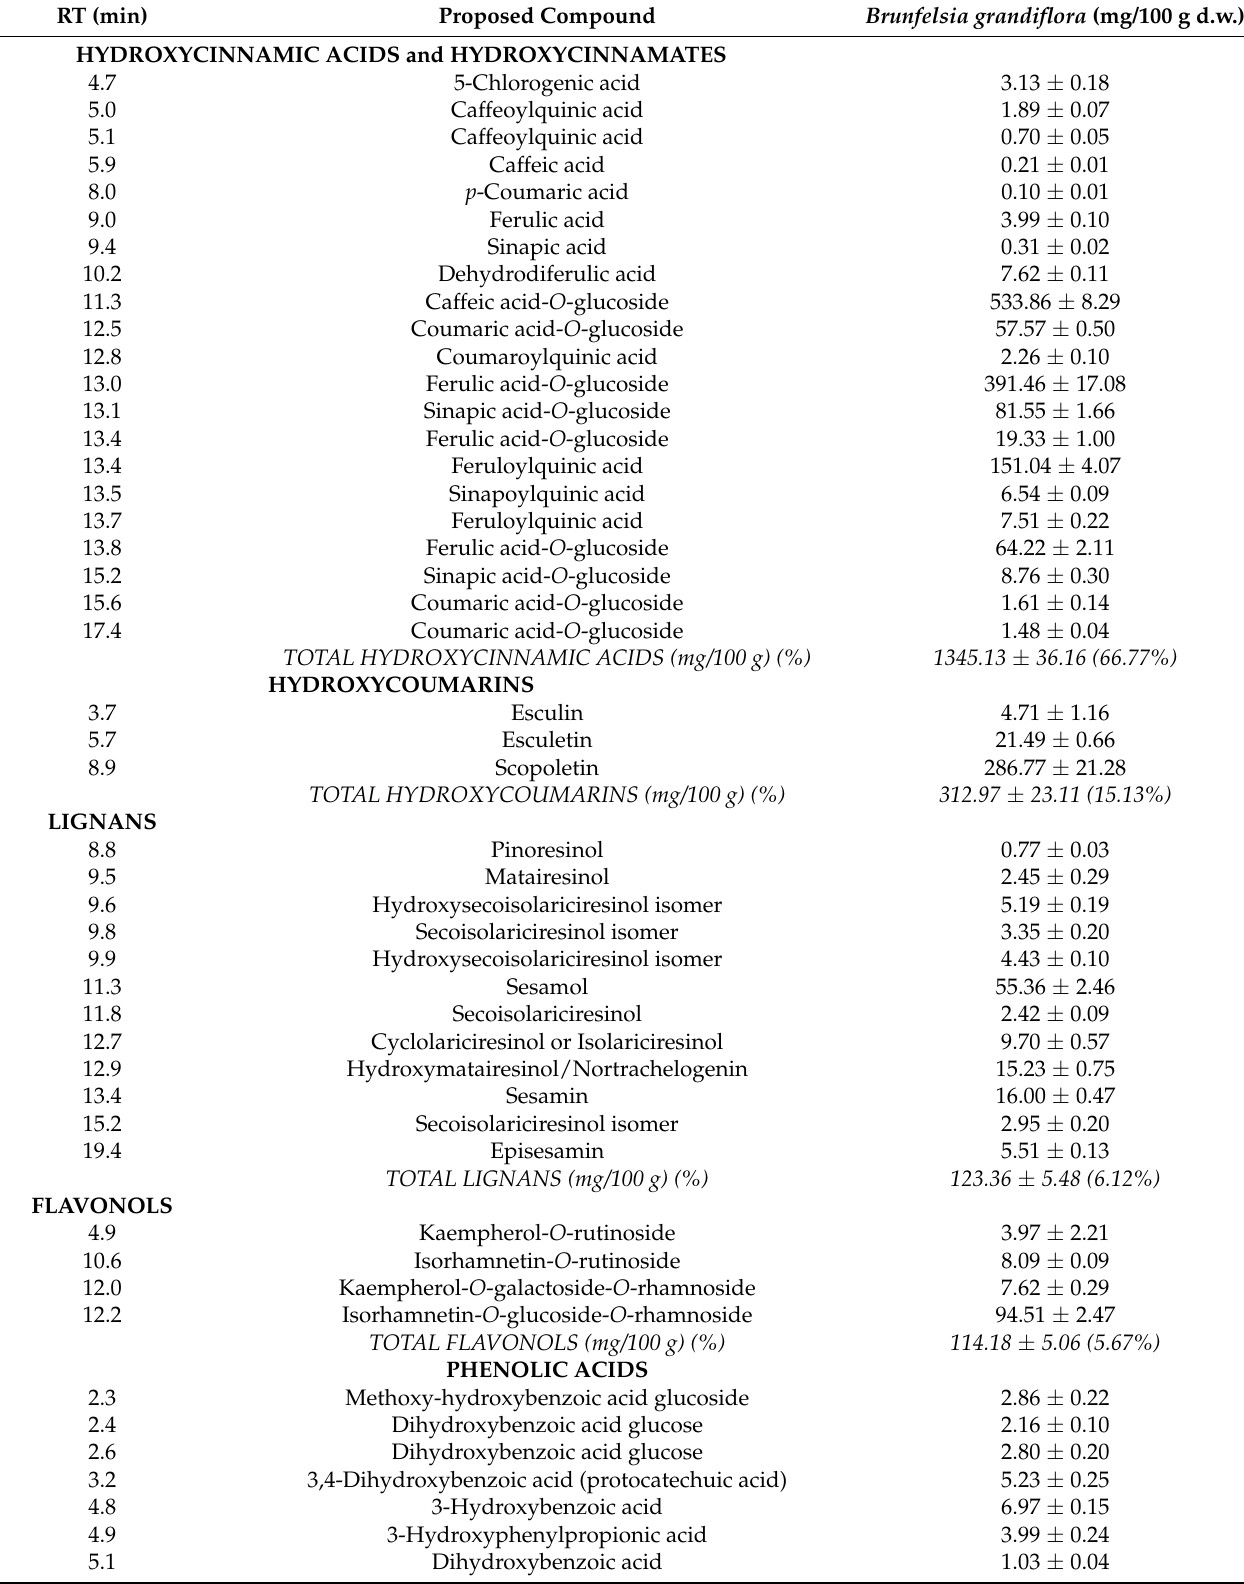
Table 3. Content of individual phenolic compounds present in Brunfelsia grandiflora . Results represent the mean ± standard deviation ( n = 4). N.D.: not detected; d.w.: dry